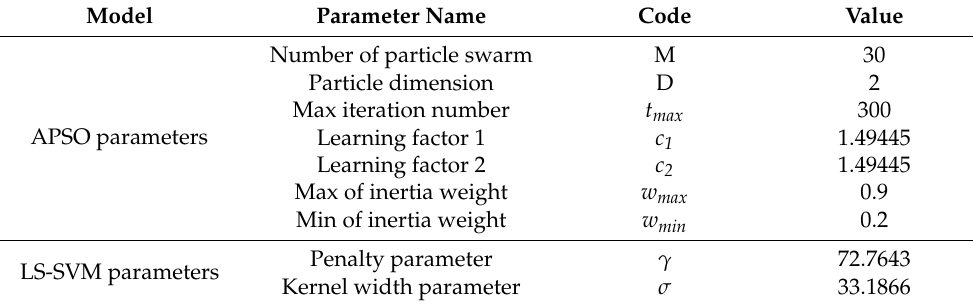
Table 3. APSO-LSSVM model parameters.